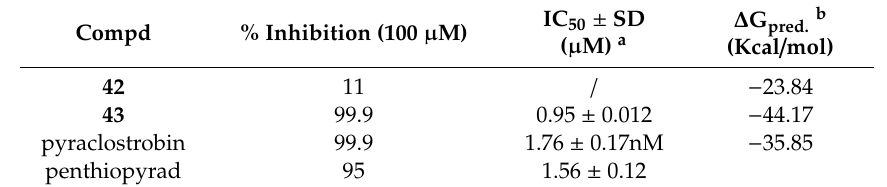
Figure 11. Structure of pyraclostrobin analogs from Reference [34]. Table 5. Percentage of inhibition, IC 50 values, and predicted total binding free energy of selected compounds against porcine SCR from Reference [34].